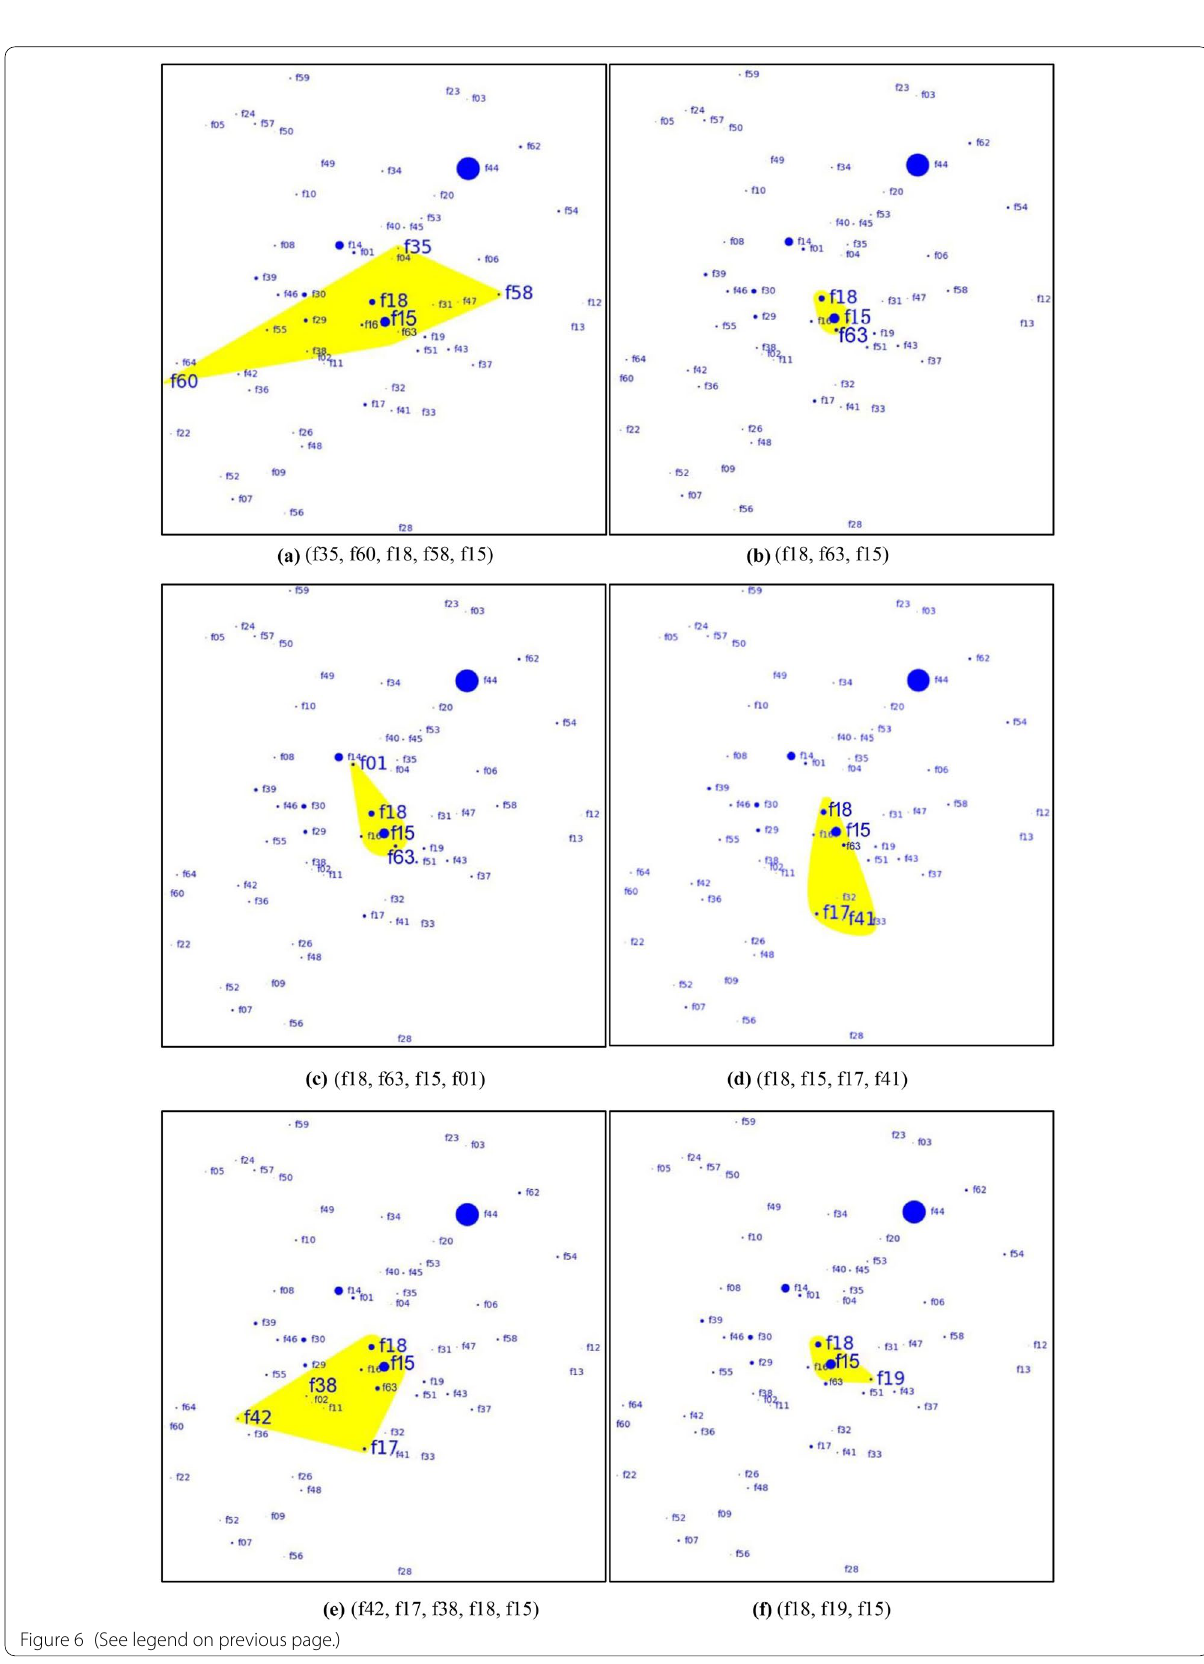
Figure 6 (See legend on previous